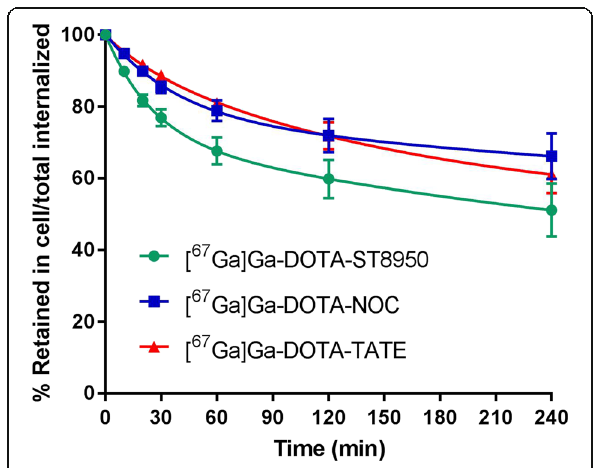
Fig. 3 Cellular retention of the 67 Ga-labeled conjugates in HEK-SST2 cells over time, expressed as % (mean ± SD) of the internalized activity